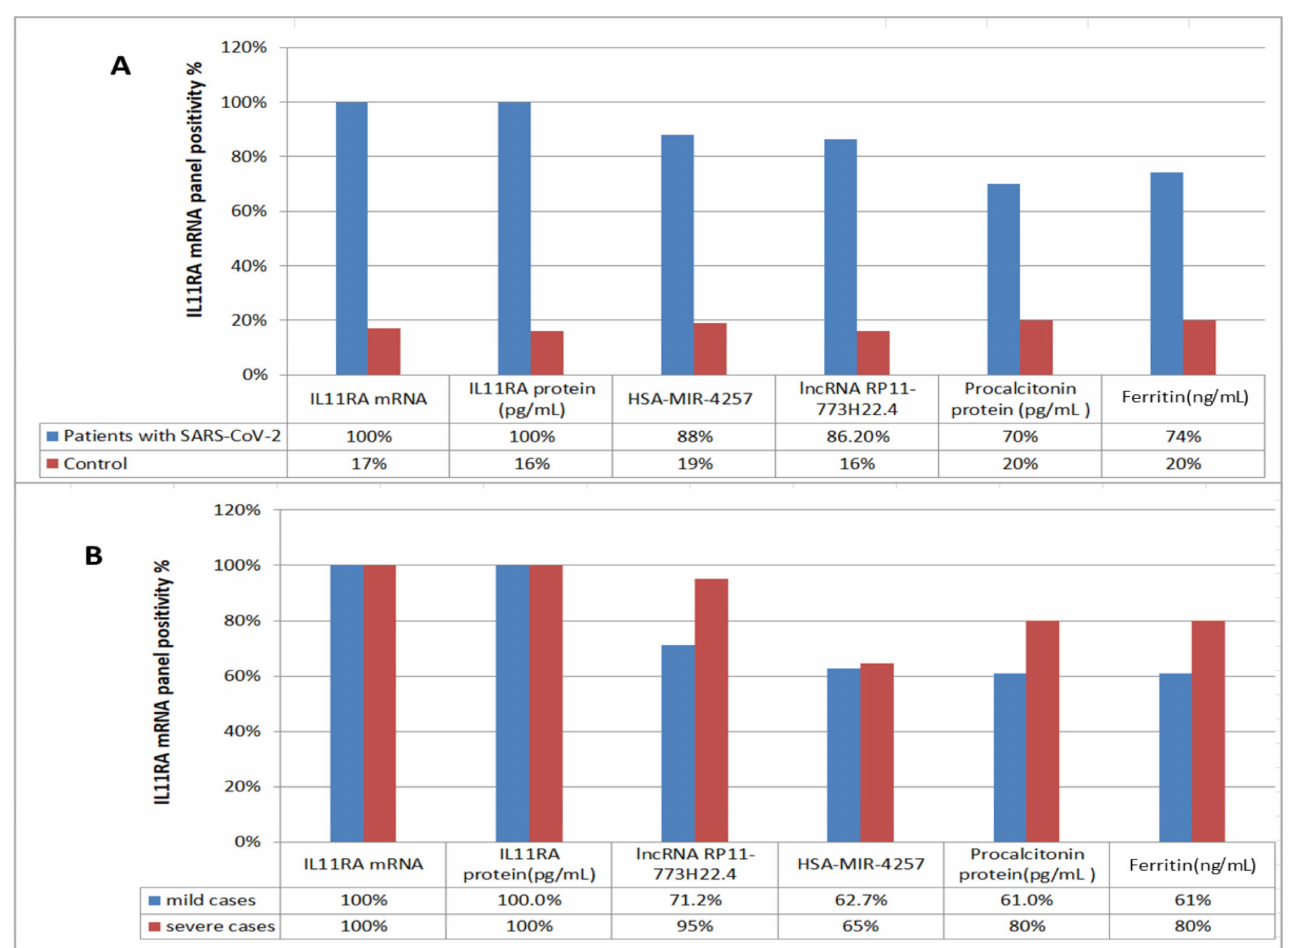
Figure 4. Bar chart showing the positivity rates of the studied parameters: ( A ) between SARS-CoV-2 patients and control, and ( B ) the diagnostic value of the studied parameters in discriminating mild from severe patients with SARS-CoV-2. Table 5. Multivariate analysis using the existing and the proposed predictors of SARS-CoV-2 severity.